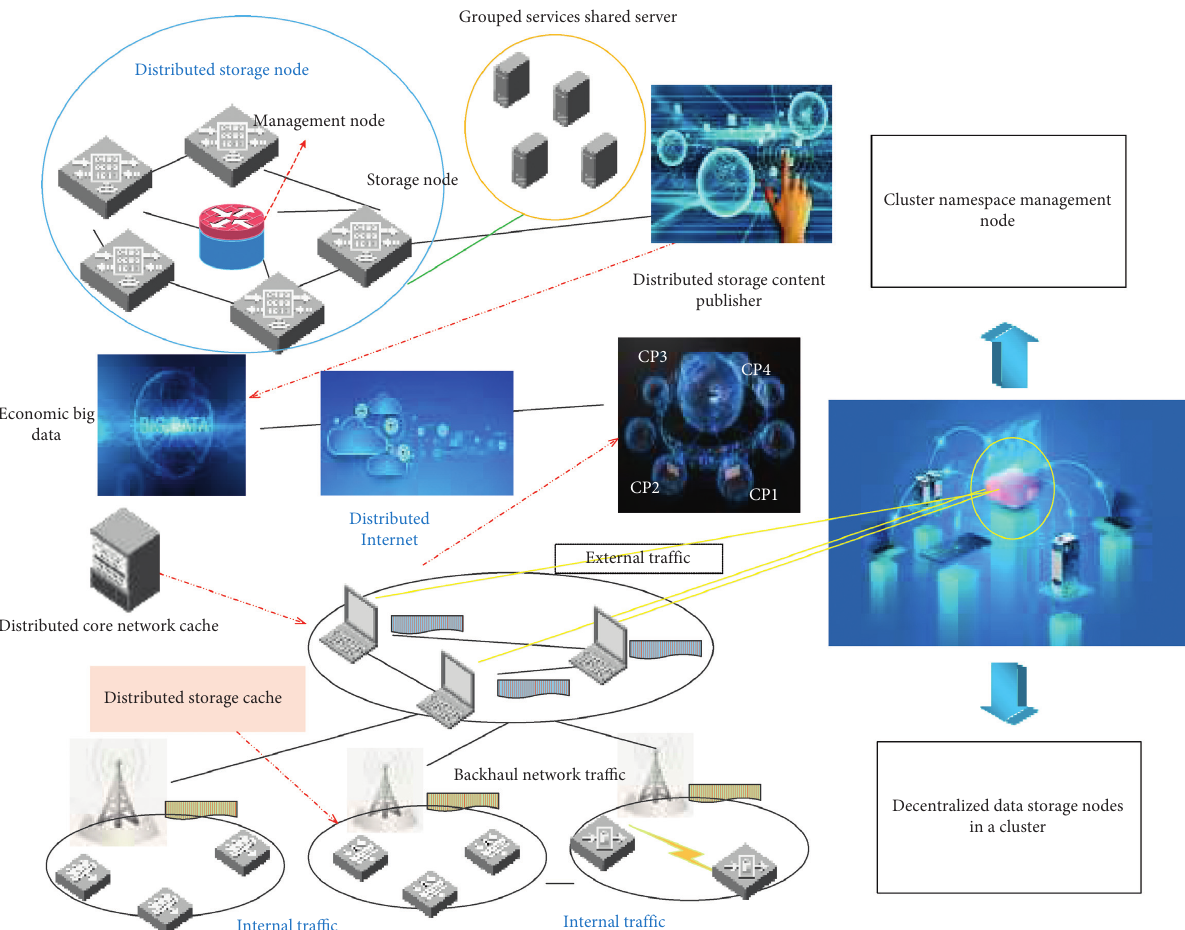
Figure 1: HDFS distributed cluster namespace management node and cluster-decentralized data storage node system